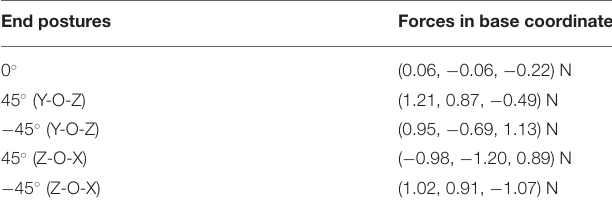
TABLE 1 | Force compensation testing results in the case of no external environment